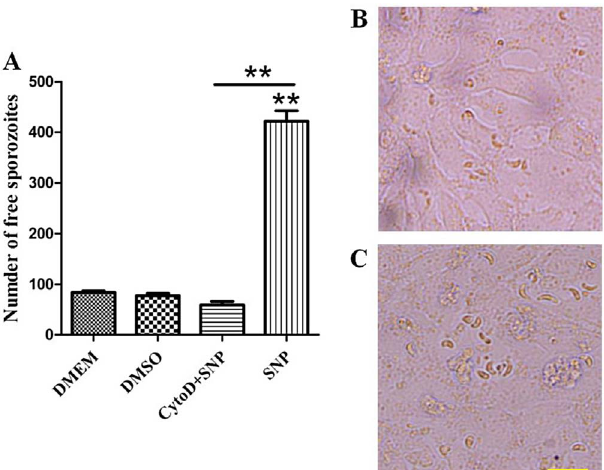
Figure 4. NO-induced egress of sporozoites is dependent on parasitic mobility . (A) Sporozoite-infected PCKs were pre-treated with 10 l M Cyto-D and then incubated with 40 mM SNP for 30 min. Free sporozoites were analyzed by fl ow cytometry. Data are means ± SEM of four replicates, representing three independent experiments. ** p < 0.01. (B) and (C) Images captured after SNP treatment and pre-incubation with 10 l M Cyto-D. Bar: 20 l m.